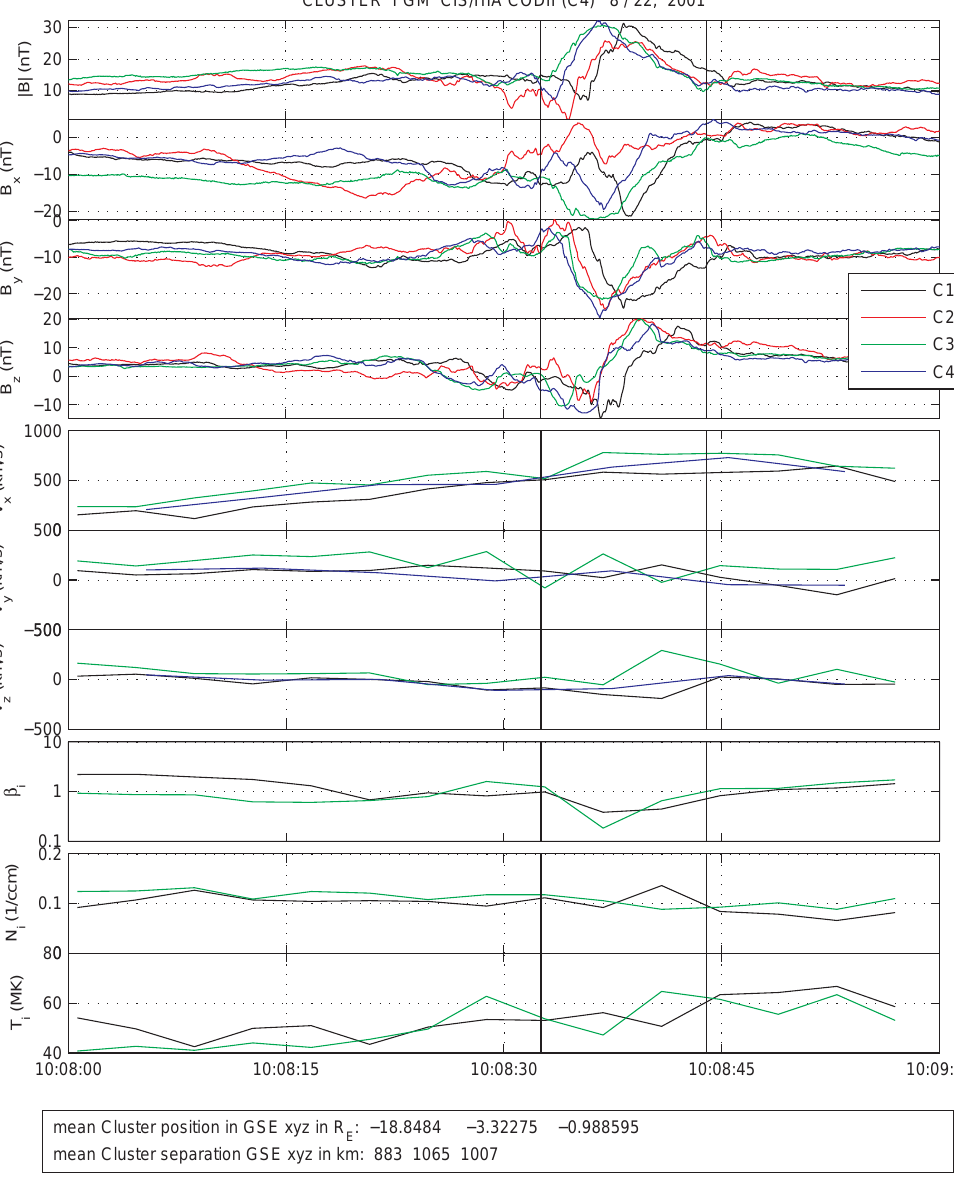
Fig. 1. Cluster magnetic field and ion/proton data for 22 August 2001, 10:08:00–10:09:00UT. From top to bottom: Magnetic field magnitude, magnetic field components (GSE), proton bulk velocity (GSE), ion beta, ion density and ion temperature. Plasma parameters are from CIS/HIA for C1 and C3, the proton velocity from HIA for C1/C3 and from CODIF for C4. The vertical lines delimit the interval 10:08:33– 10:08:44UT used for the